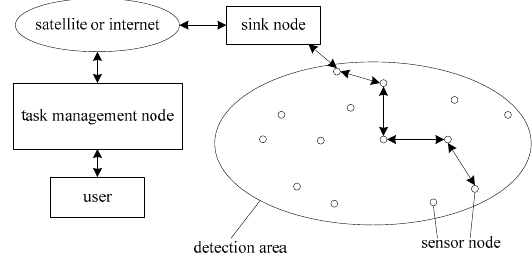
Figure 1. The architecture of WSNs.